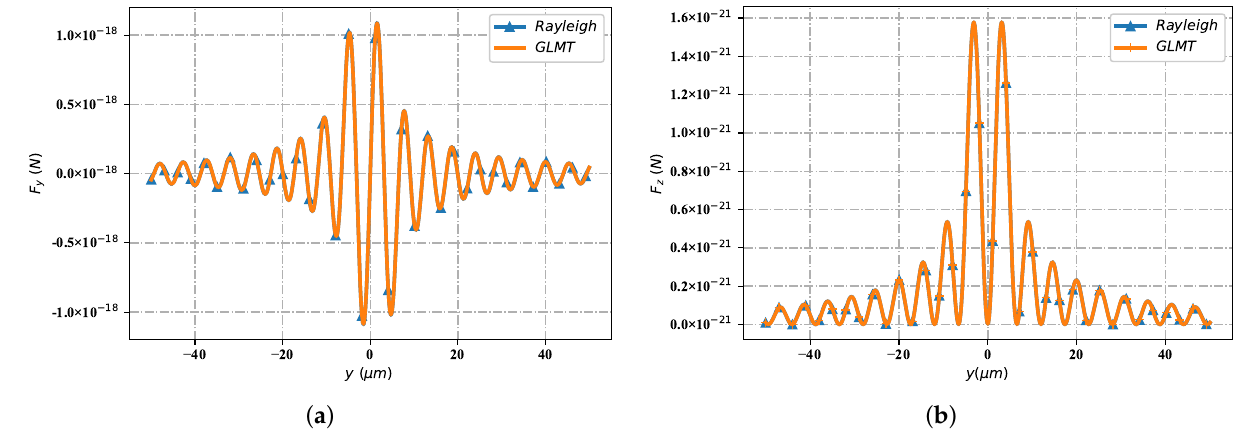
Figure 3. Validation of different F y and F z with Rayleigh and GLMT. ( a ) F y ; ( b ) F z